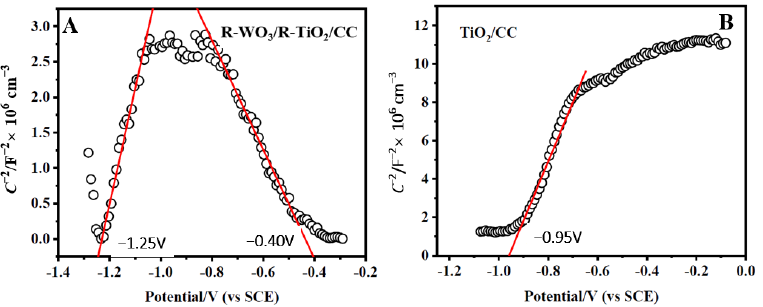
Figure 10. Mott – Schottky (M – S) of R-WO 3 /R-TiO 2 /CC ( A ) and TiO 2 /CC ( B ) with 5000 Hz of fre- quency at 10 mV of amplitude.